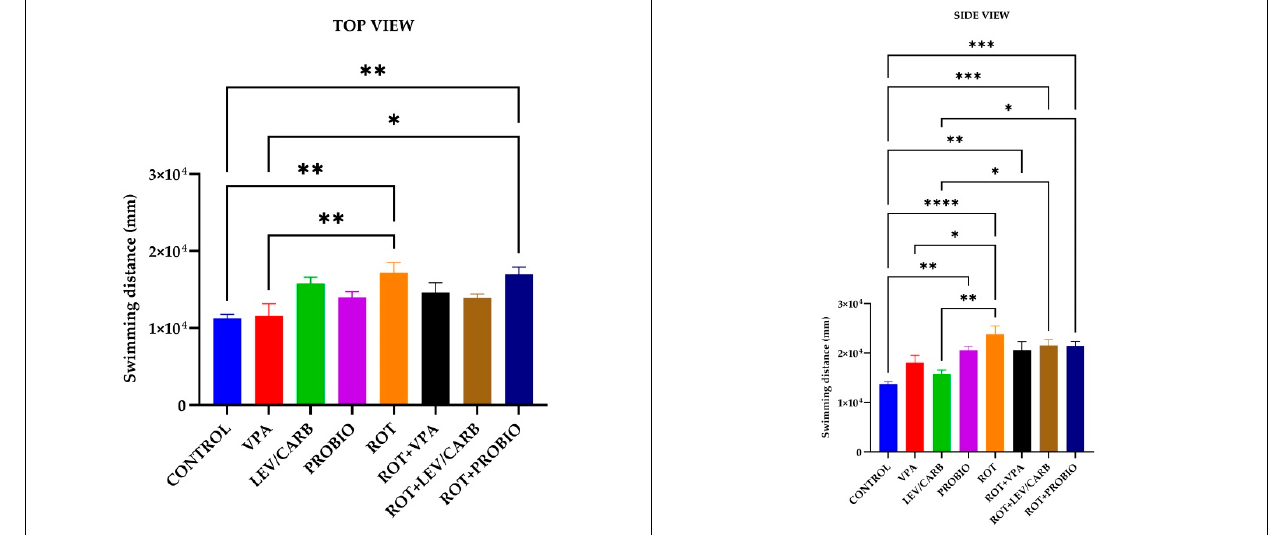
Figure 2. Swimming distance (mm) patterns in studied Danio rerio ( n = 5) groups (*— p < 0.05; **— p